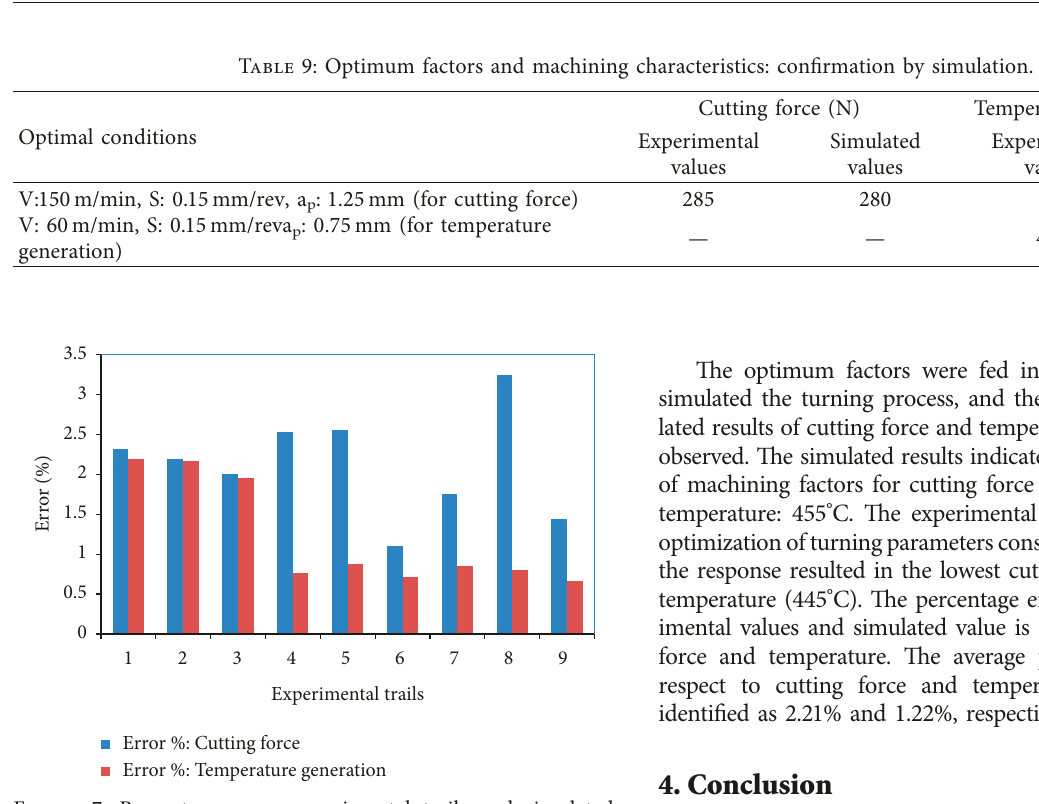
Figure 7: Percentage error: experimental trails and simulated results: cutting force and